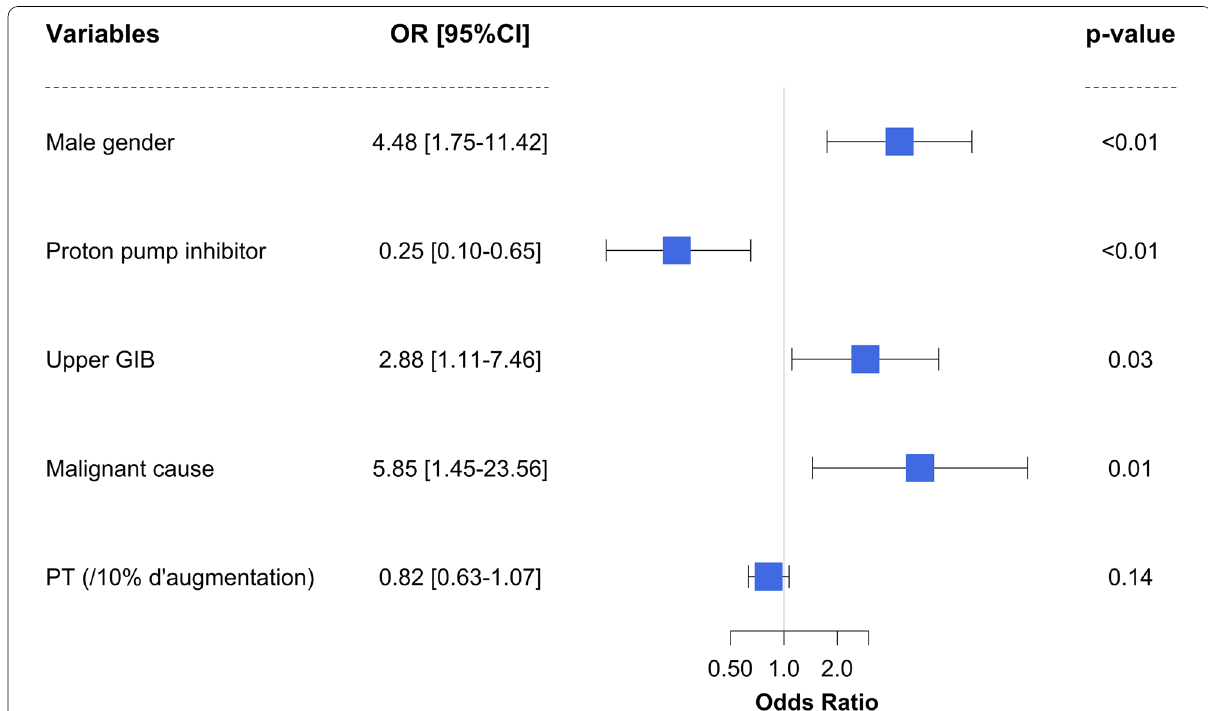
Fig. 2 Factors associated with severe gastrointestinal bleeding by multivariate analysis. GIB gastrointestinal bleeding, PT prothrombin